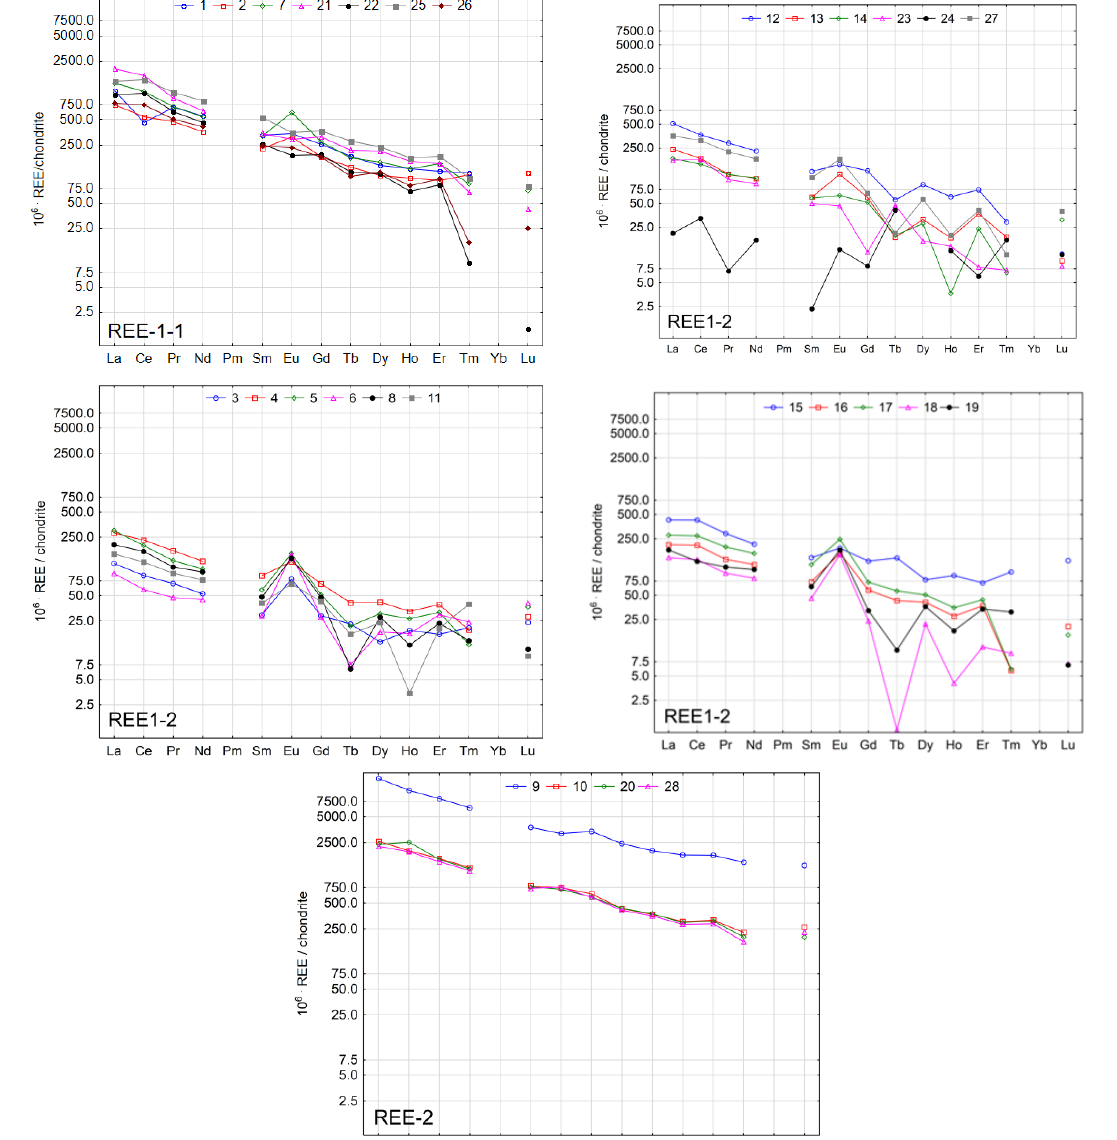
Figure 4. Chondrite — normalised REE patterns in spring waters. Figure 4. Chondrite—normalised REE patterns in spring